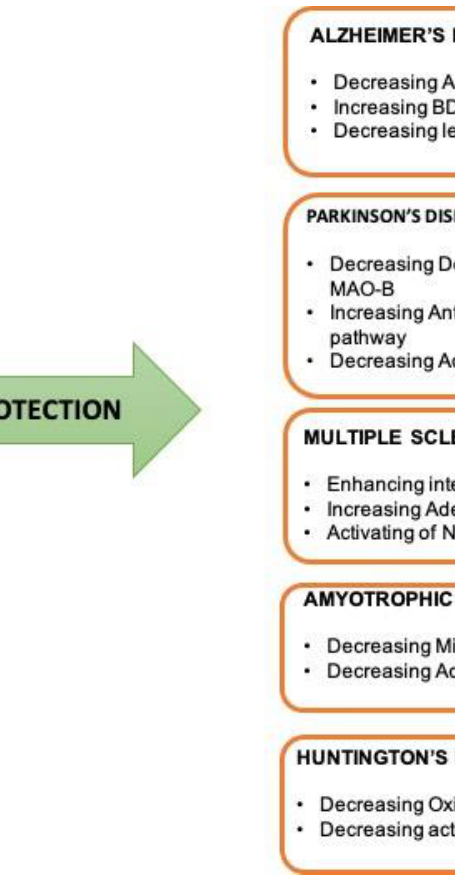
Figure 3. The neuroprotective effects of caffeine in neuroinflammatory and neurodegenerative disease.